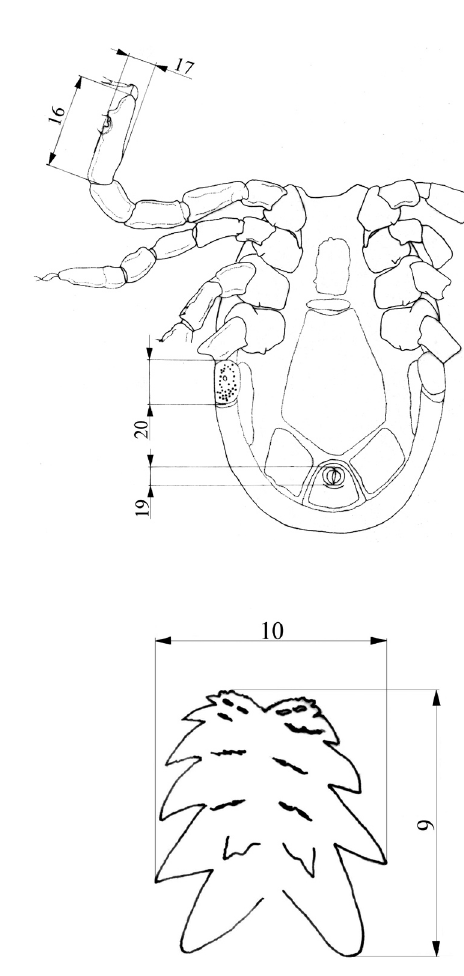
Table I. – Morphometric data of male of Ixodes festai (4 specimens